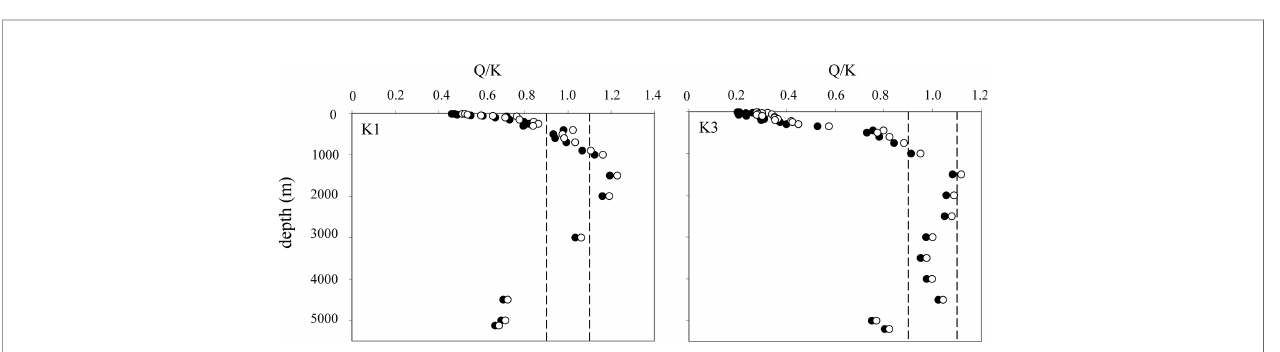
FIGURE 3 | Barite saturation index pro fi les at stations K1 and K3, considering either pure barite, BaSO 4 (black circles) or (Ba,Sr)SO 4 (open circles) in the calculations. Undersaturation is indicated by a saturation index lower than